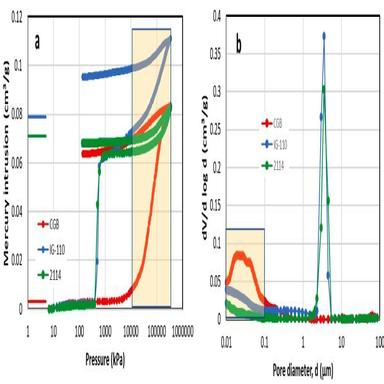
Comparison of open pores properties in CGB vs. IG-110 and 2114 superfine nuclear graphites. Data were obtained via mercury porosimetry: (a) raw mercury intrusion and extrusion data vs. mercury pressure, and the open-pore volumes from helium pycnometry; (b) logarithm differential intrusion vs. pore size (diameter) of externally accessible pores assumed cylindrical. The yellow shaded regions indicate possible structural changes caused by extreme mercury pressures.